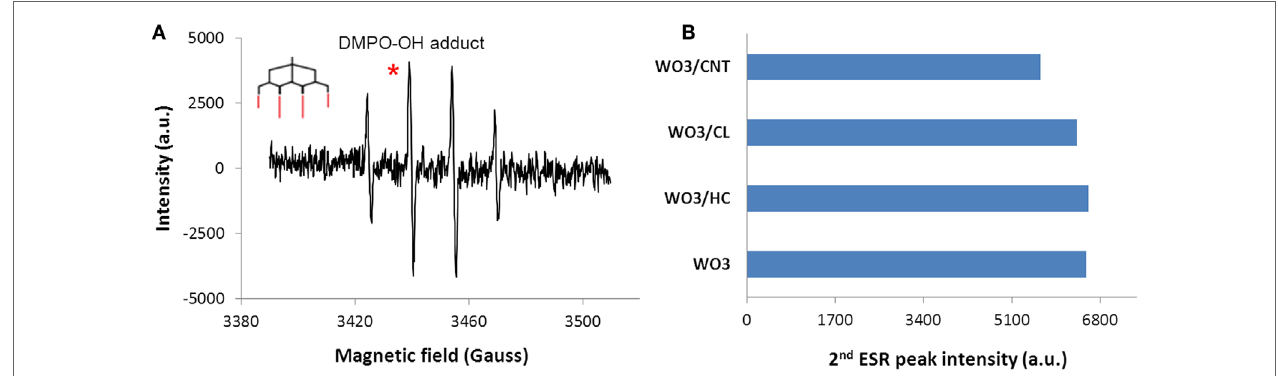
FigUre 7 | (a) Characteristic ESR signal of DMPO-OH adduct (inset) obtained upon 20 min of irradiation of an aqueous suspensions of the WO 3 /carbon photocatalysts, (B) Quantification of the radical species detected from the ESR signals corresponding to DMPO-OH adducts by integration of the second peak in the 1:2:2:1 quartet profile (marked